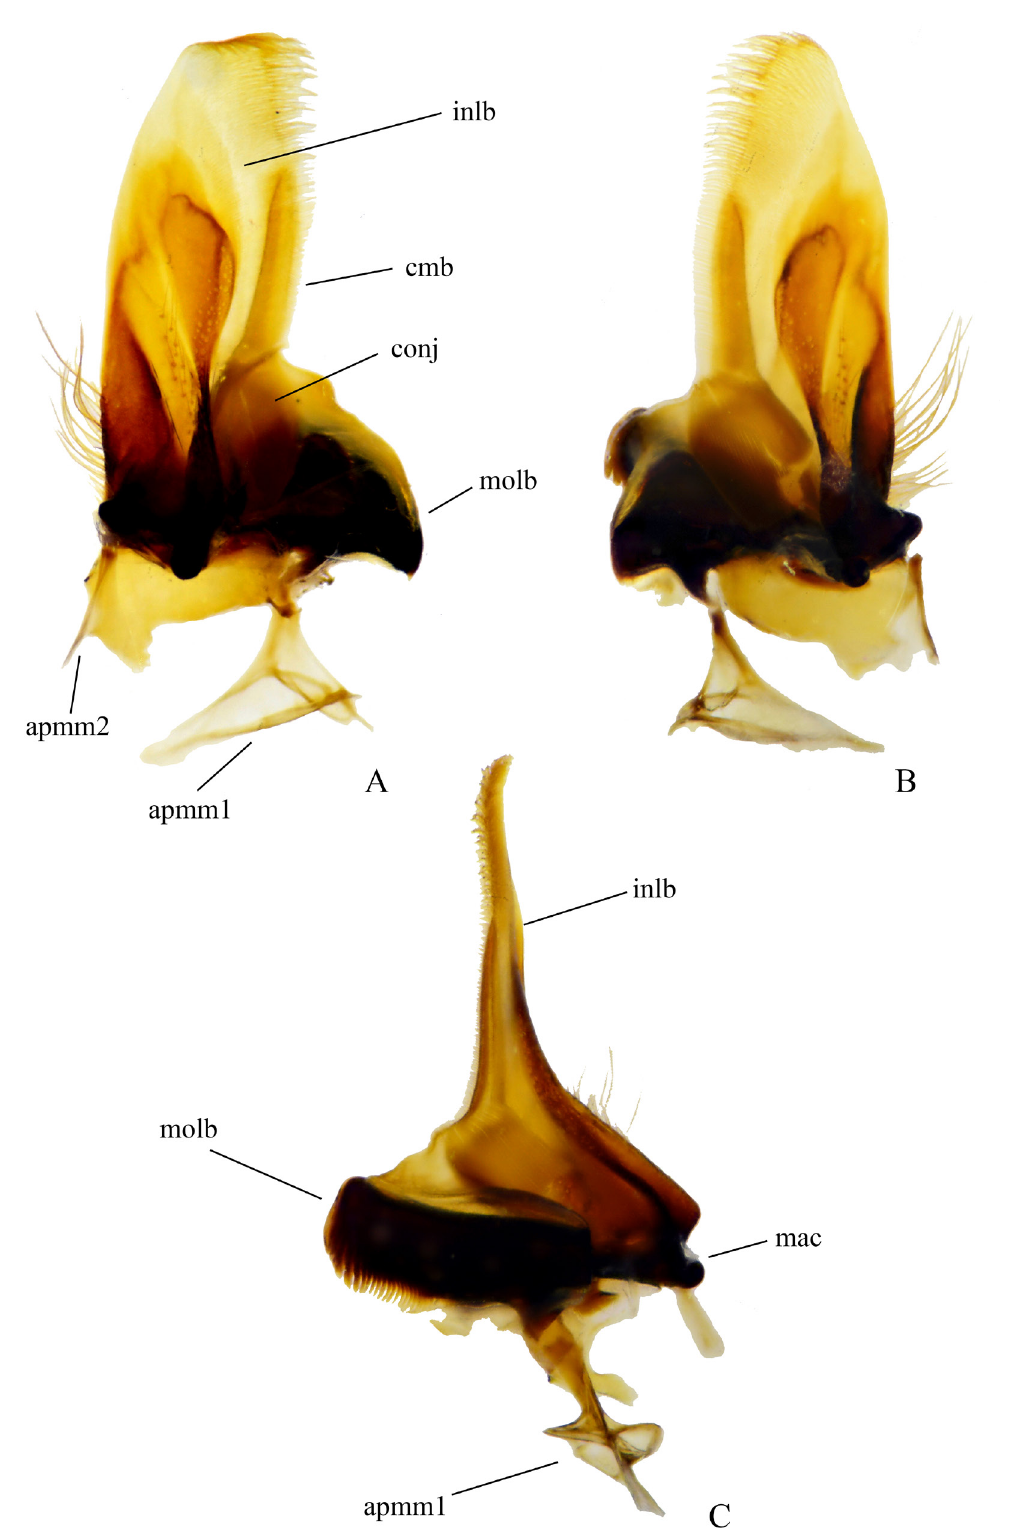
Fig. 9. Mandibles of Streblopus opatroides van Lansberge, 1874. A‒B . Ventral view. A . Left mandible. B . Right mandible. C . Lateral view of right mandible. Abbreviations: apmm = apodemes of mandibular muscles; cmb = comb of incisor lobe of mandible; conj = conjunctivus of mandible; inlb = incisor lobe of mandible; mac = mandibular acetabulum; molb = molar lobe of